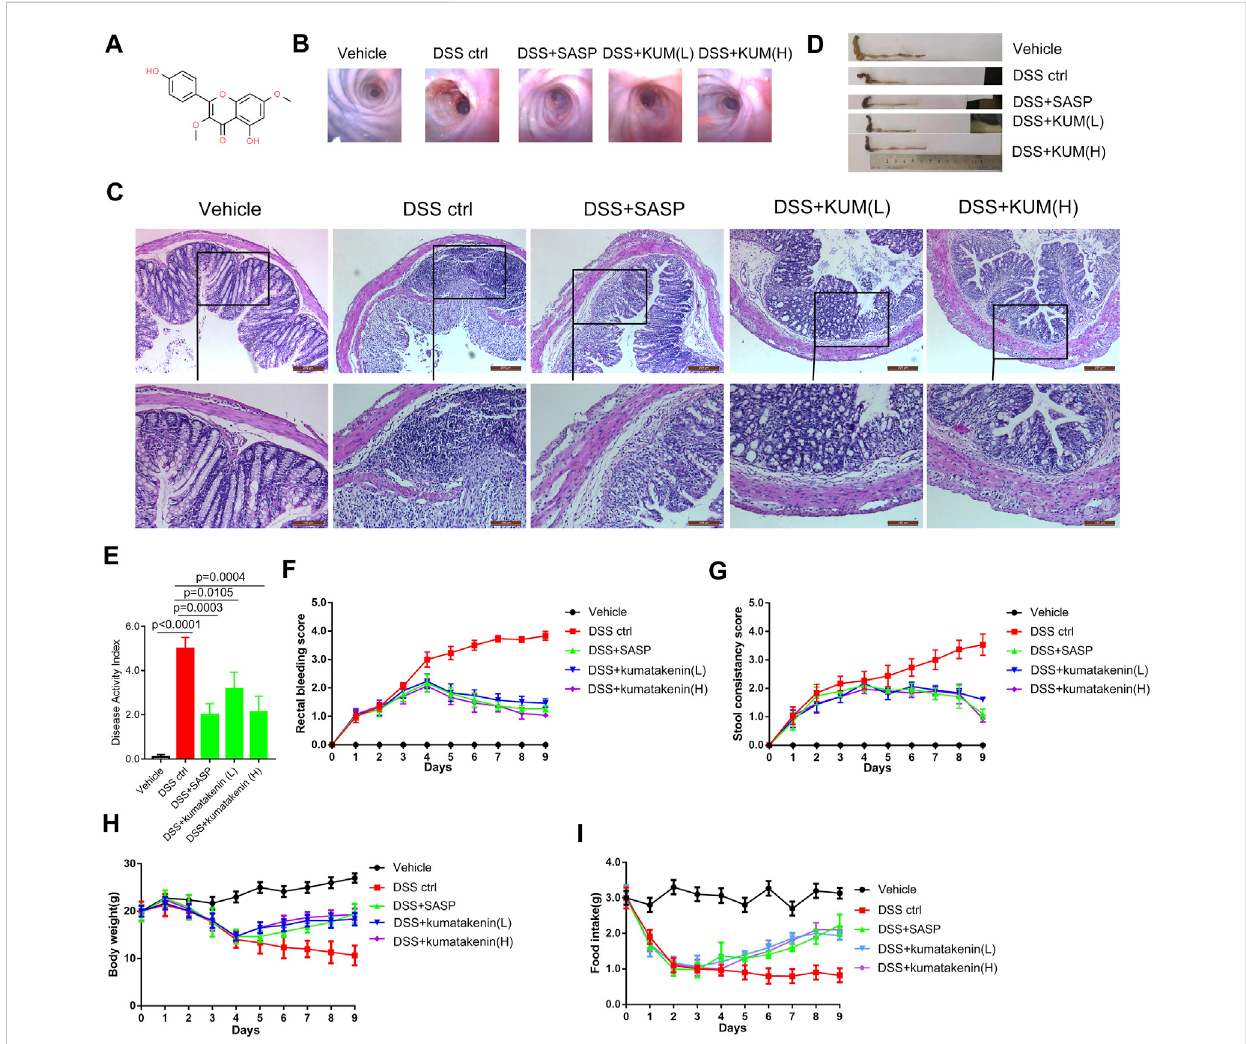
Effects of kumatakenin treatment on DSS-induced colitis in mice. (A) Chemical formula of kumatakenin. Mice were administered DSS to induce colitis. (B) Colonoscopy and (C) hematoxylin and eosin (HE) staining of mice colonic tissue was performed to measure the effects of kumatakenin on vascular patterns, atrophy of intestinal villi, and in fi ltration of in fl ammatory cells (above: scale bar = 200 μ m; below: scale bar = 100 μ m). Effects of kumatakeninon (D) colonlength, (E) diseaseactivityindex, (F) rectalbleedingscore, (G) stoolconsistencyscore, (H) bodyweight,and (I) foodintake inmicewith colitis. Data areexpressedas themean± standard deviation(SD).SASP, sulfasalazine; kumatakenin (L),25 mg/kgkumatakenin; kumatakenin (H) , 100 mg/kg